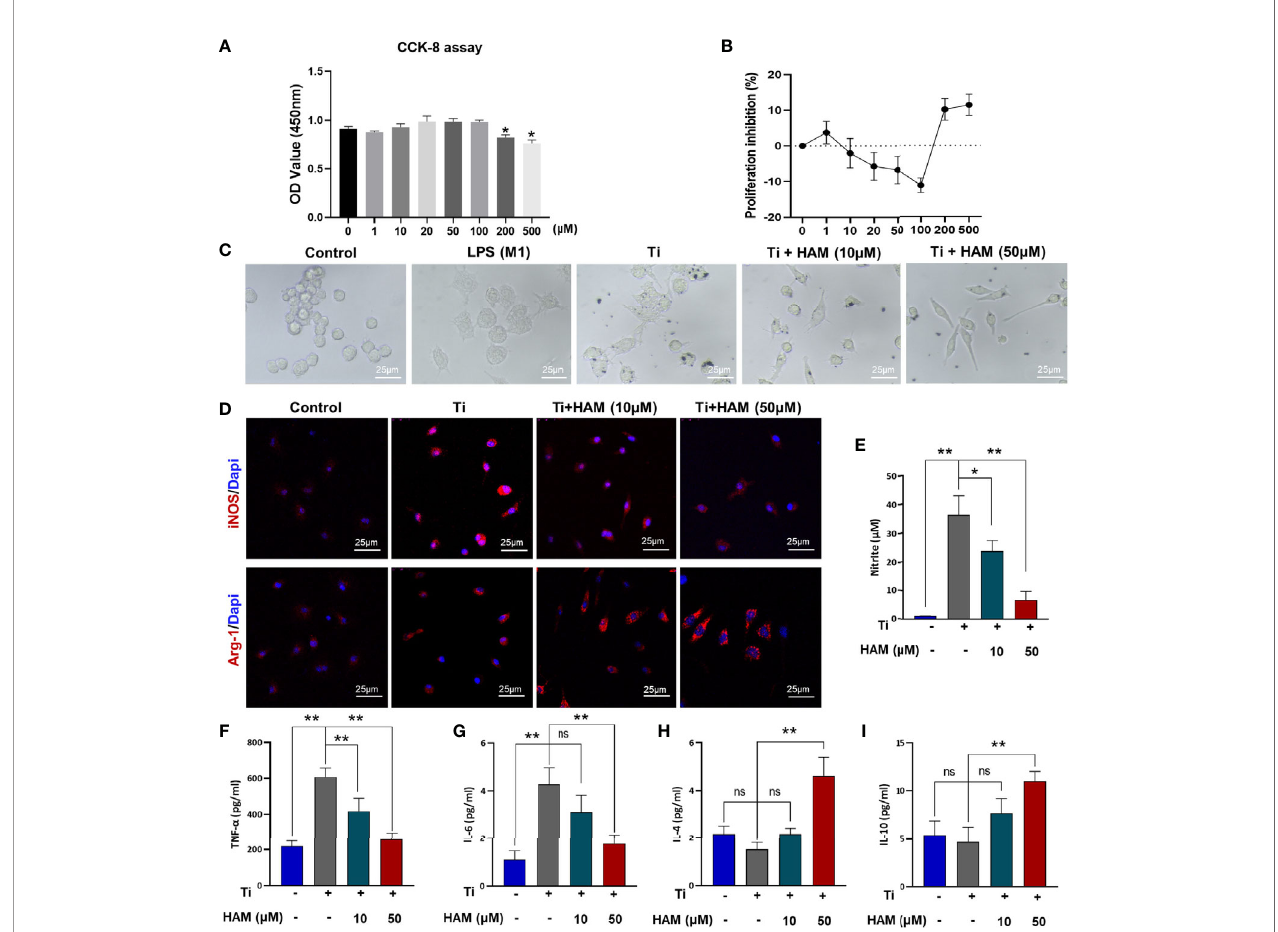
FIGURE 5 | Harmine promoted the polarization of macrophages from M1 to M2 in vitro . (A) Cell proliferation was evaluated by CCK-8 assay. (B) Proliferation inhibition of harmine on RAW macrophages. (C) Morphology of RAW macrophages by a light microscope. Scale bar indicates 25 m m. (D) Representative immuno fl uorescent staining images: red (M1 marker: iNOS and M2 marker: Arg-1), and blue (Dapi, directing against nuclei). (E) NO content determined by Griess reagent. (F – I) Protein level expressions of in fl ammatory cytokines in Ti particles-treated macrophages (measured by ELISA). Scale bar indicates 25 m m. n = 3. All data were expressed as the mean ± SD, ns, no signi fi cance; * p < 0.05, ** p < 0.01, compared with the Ti